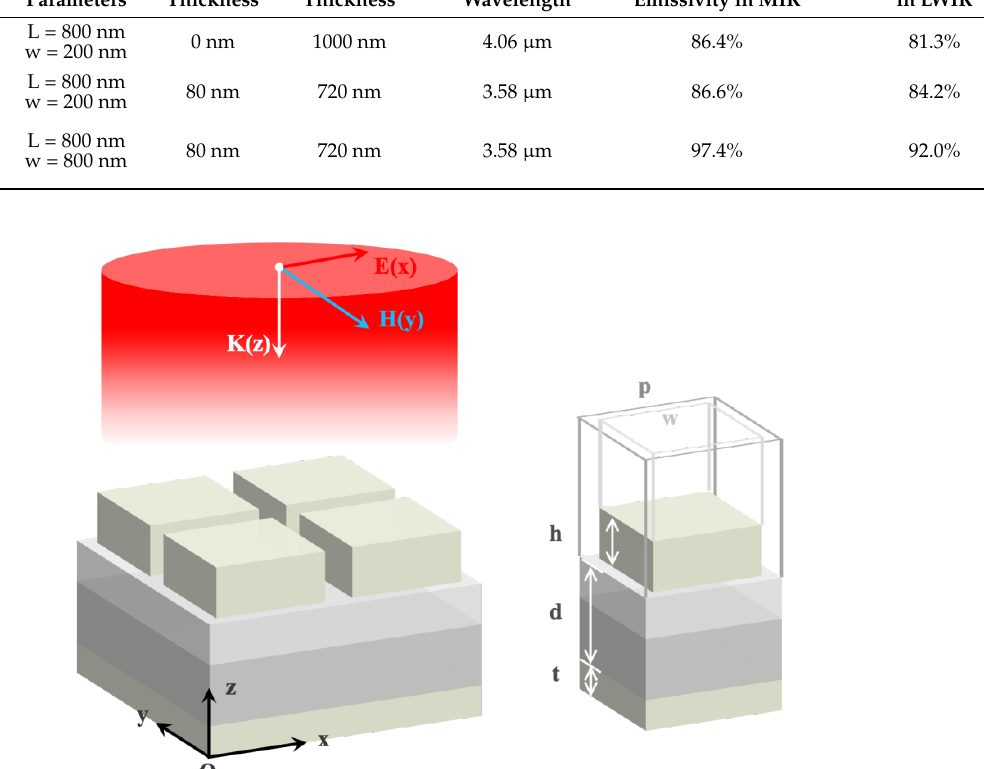
Figure 2. Diagram of designed metasurface S3 with p = 1000 nm, w = 800 nm, h = 100 nm, d = 800 nm, and t = 100 nm.